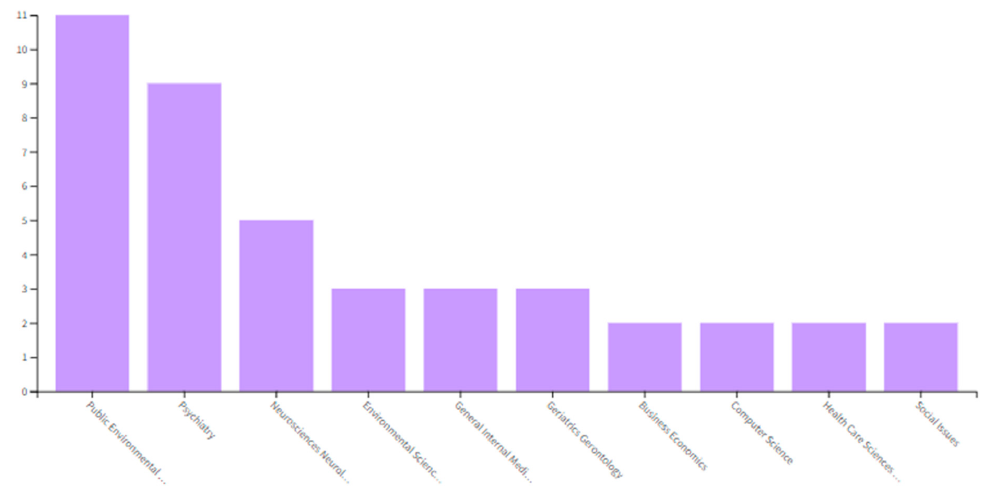
Figure 7. Publications by scientific area—Web of Science.